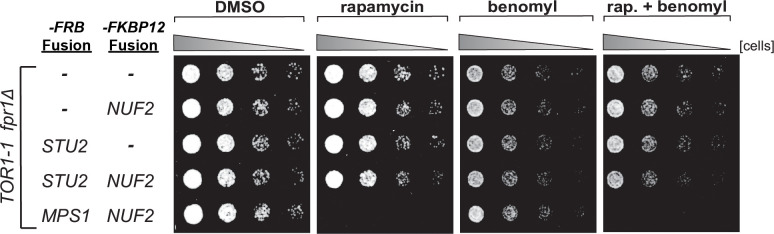
Characterization of STU2-FRB and NUF2-FKBP12 fusion alleles.fpr1Δ TOR1-1 cells (M1375), and fpr1Δ TOR1-1 cells expressing -FRB and/or -FKBP12 fusion alleles at the endogenous fusion-target locus (NUF2-FKBP12, M1422; STU2-FRB, M1387; STU2-FRB NUF2-FKBP12, M1428; MPS1-FRB NUF2-FKBP12, M1461) were serially diluted (fivefold) and spotted on plates containing DMSO, 50 ng/mL rapamycin, 3.5 µg/mL benomyl, or 3.5 µg/mL benomyl + 50 ng/mL rapamycin. Note: tethering Stu2-FRB to Nuf2-FKBP12 does not affect cell viability, whereas tethering Mps1-FRB results in lethality, as previously reported (Aravamudhan et al., 2015).